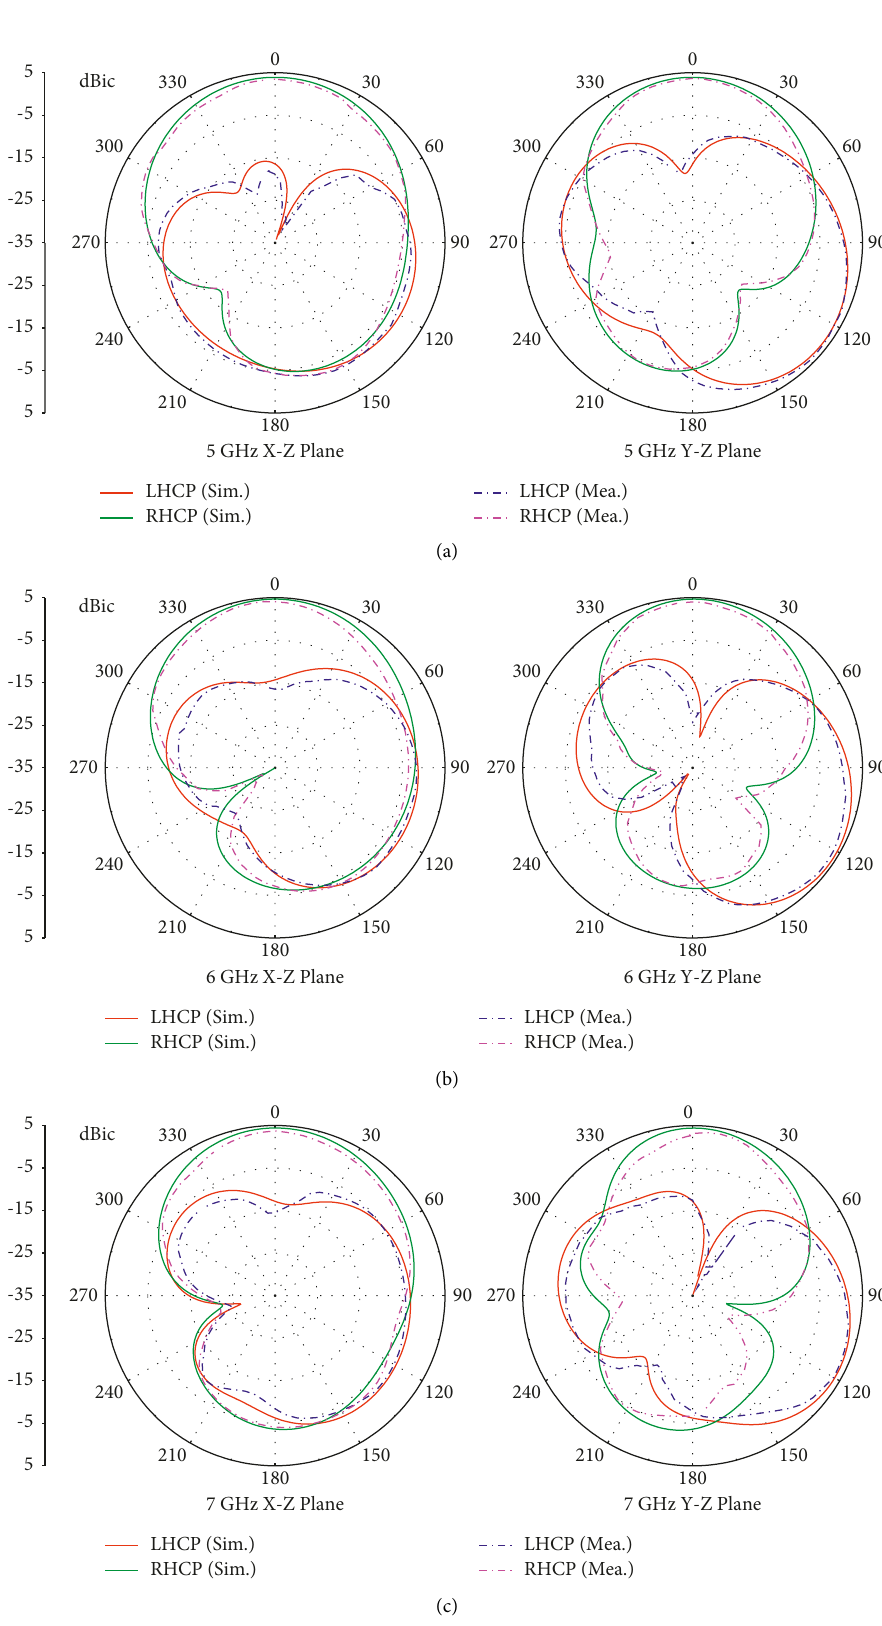
Figure 14: Simulated and measured radiation patterns of An1 at (a) 5GHz, (b) 6GHz, and (c)